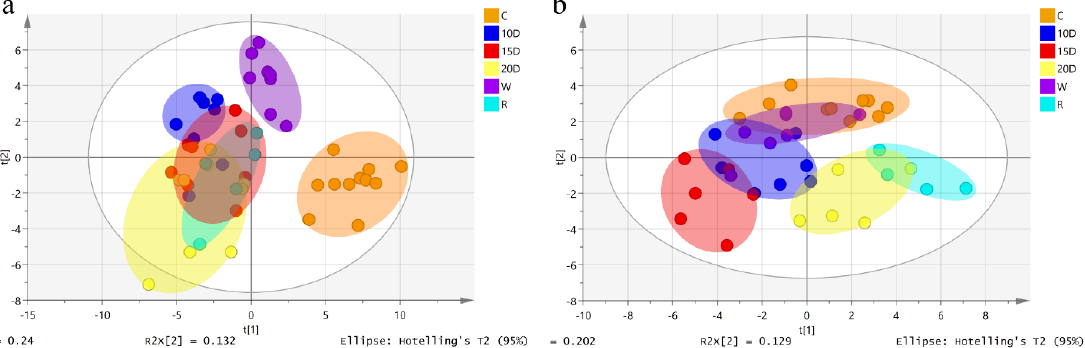
Figure 3. PLS ‐ DA model of metabolic patterns for mice. ( a ) Serum. ( b ) Urine. The blue points rep ‐ resent the group of 10 days; the red points represent the group of 15 days; the yellow points rep ‐ resent the group of 20 days; the purple points represent the group of withdrawal (withdrawal for 5 days after 10 days’ administration); the cyan points represent the group of relapse (re ‐ administration for 5 days after the